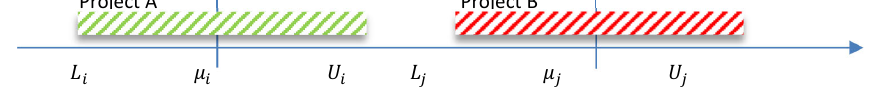
Fig. 6. Possible Condition 1- Different Means and Similar Domain Length